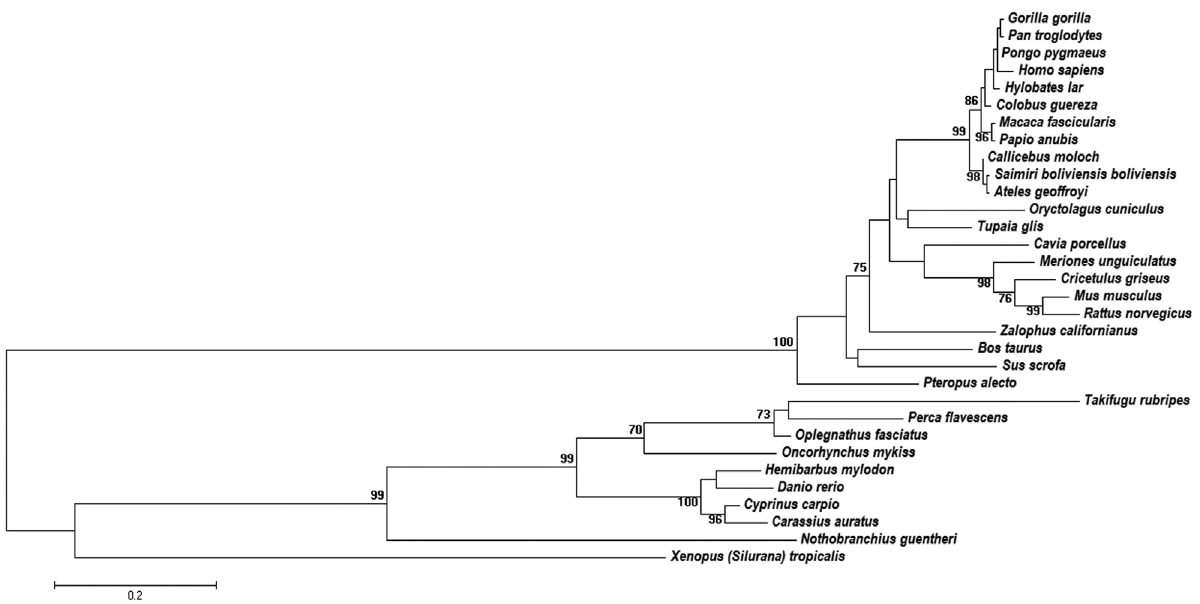
Figure 1 - Phylogenetic tree of apo E sequences constructed by the ML method. The bootstrap analysis was performed with 1000 pseudoreplicates. Boot- strap values lower than 70% are not shown. The evolutionary distances were computed using the Jones-Taylor-Thornton (JTT)